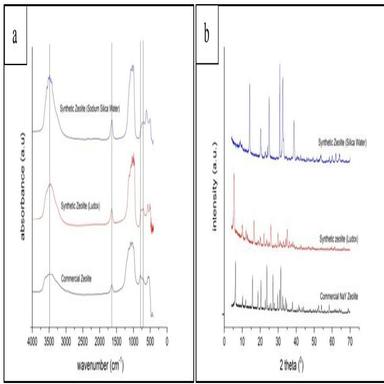
). FTIR spectra and (b) XRD of NaY zeolite from synthetic materials